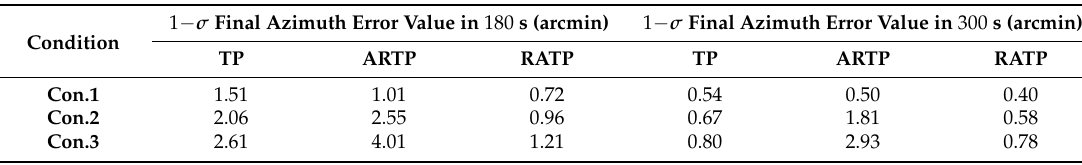
Table 2. Performance comparison of three alignment schemes.